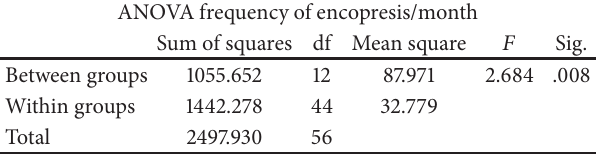
Table 2: Encopresis frequency and relation with the level of education of the patients’ female next of kin.